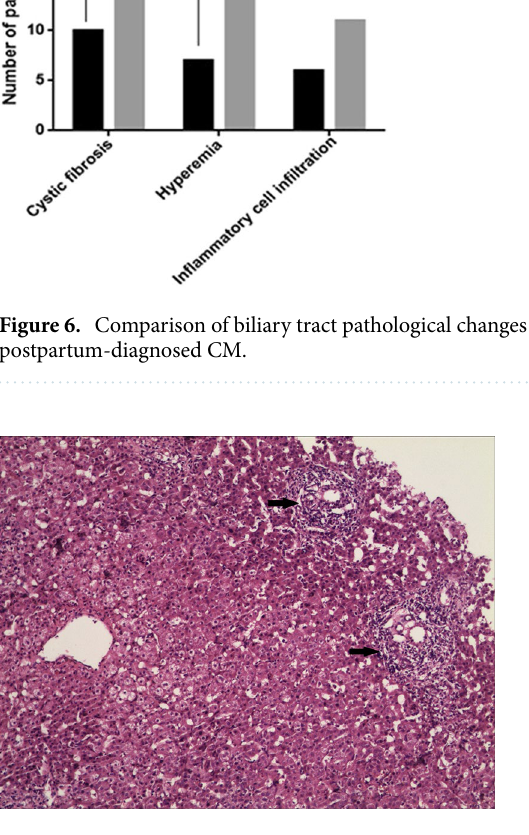
Figure 7. H&E staining showed proliferation of fibrous tissue and lymphocyte infiltration (arrow) in the portal area (× 200